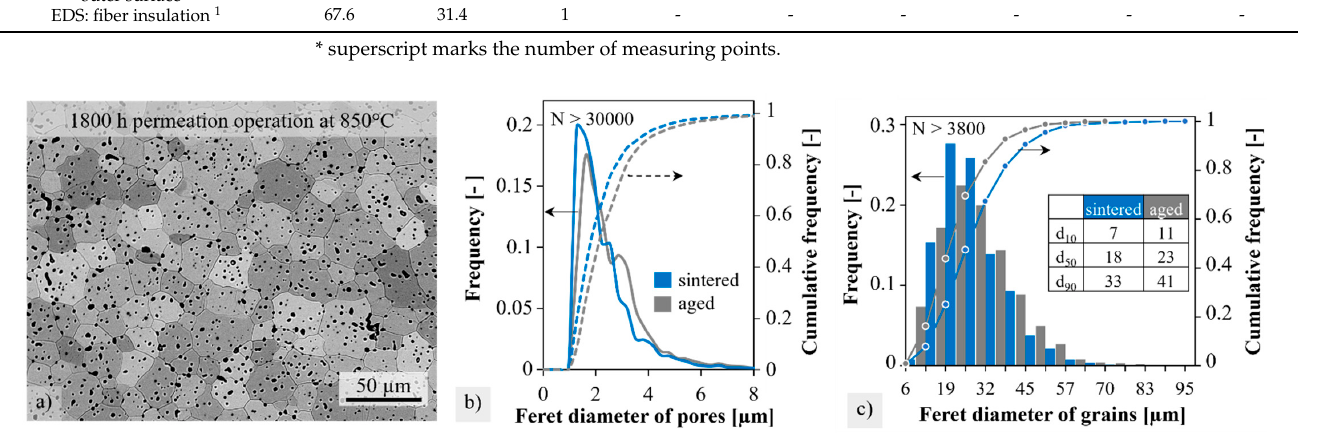
Figure 6. ( a ) Exemplary BSE image of BSCF after thermal etching, ( b ) pore sizes and ( c ) grain size distribution of BSCF in the sintered condition and after 1800 h aging at 850 °C in module permeation.